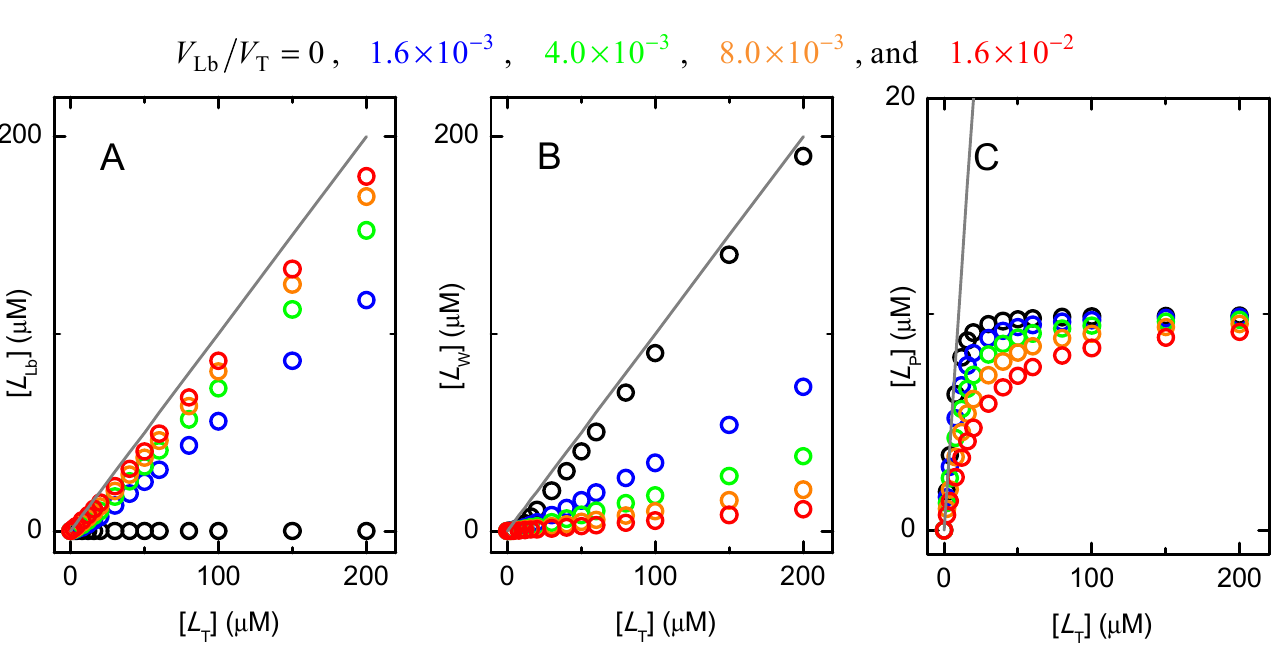
Figure A1. Dependence of the amount of ligand associated with the lipid bilayer (plot ( A )), in the aqueous medium (plot ( B )), and bound to the protein (plot ( C )), with the total ligand concentra- tion. The system includes a water-soluble protein with M W = 50 kDa and a total concentration of [ P T ] = 10 µ M (corresponding to V P = 4.2 × 10 − 4 V T ), to which the ligand binds with the intrinsic affinity for the protein ( K L W eq ) of 10 6 M − 1 and for a ligand partition towards the lipid bilayer ( K L W equal to 10 3 ; in the absence of a lipid bilayer, and in the presence of increasing volumes of the lipid bilayer as indicated in the